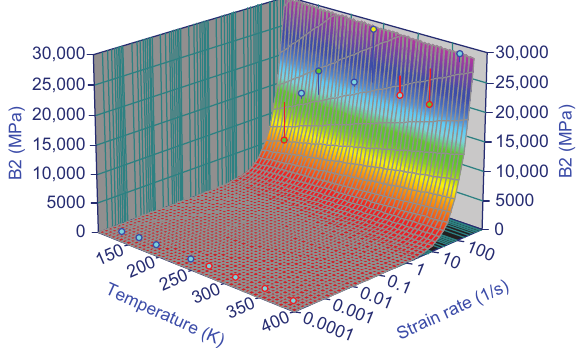
vs. temperature and 2